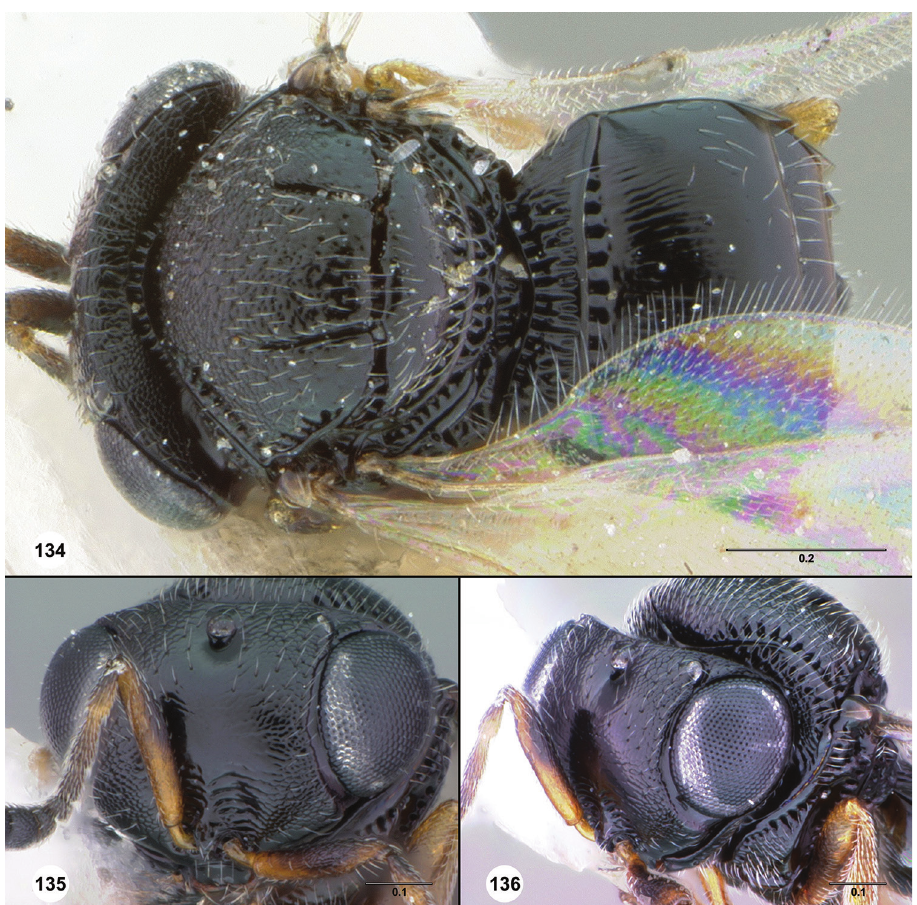
Figures 134–136. Trissolcus plautiae 134 female paratype (USNMENT00903180), head, mesosoma, metasoma, dorsal view 135 female (USNMENT00872403), head, anterior view 136 female paratype (USNMENT00872403), head and mesosoma, anterolateral view. Scale bars in millimeters. oscutum. Median protuberance on anterior margin of mesoscutellum: absent; present. Protruberance on anterior margin of mesoscutellum directly posterior to notaulus: pre- sent. Shape of dorsal margin of anterior lobe of axillar crescent: round. Sculpture of anterior lobe of axillar crescent: dorsoventrally strigose. Area bounded by axillar cres- cent: striate. Macrosculpture of mesoscutellum: absent. Microsculpture on mesoscutel- lum: absent. Median mesoscutellar carina: absent. Setation of posterior scutellar sulcus: present. Form of metascutellum: single row of cells. Metanotal trough: foveate, foveae occupying more than half of metanotal height. Metapostnotum: invaginated near lat- eral edge of metascutellum. Length of postmarginal vein: about twice as long as stigmal vein. Color of legs: coxae dark brown, femora yellow to dark brown, elsewhere yellow. Anteromedial portion of metasomal depression: punctate or